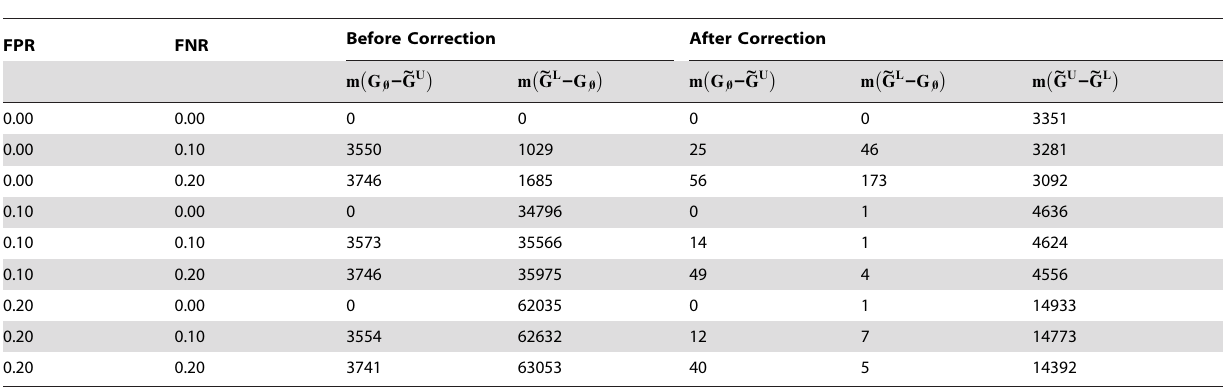
Table 3. Ensemble inference of E. coli